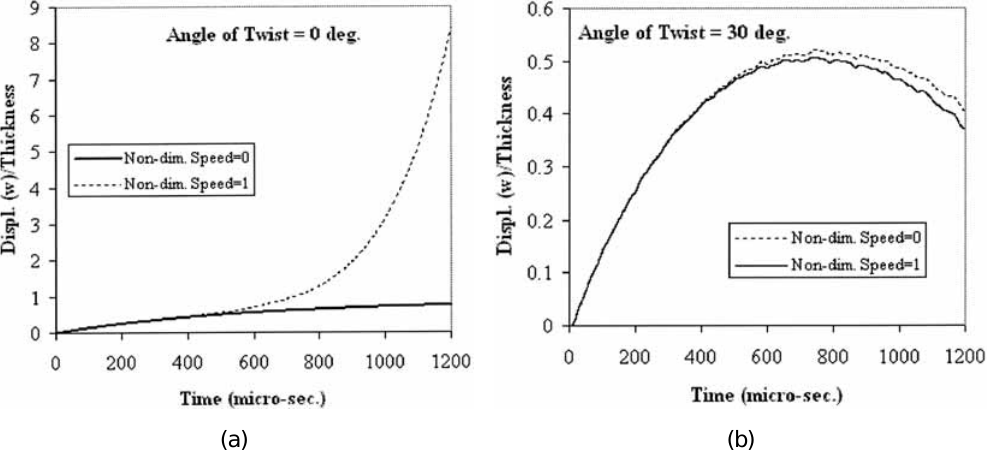
Fig. 5. (a) The effect of rotational speed on central deflection for bending stiff ([0 2 / ± 30] S ) graphite-epoxy composite cantilever cylindrical shell with 25% mid-plane delamination (relative position of centre line at 0.25 from the fixed end). (b) The effect of rotational speed on central deflection for bending stiff ([0 2 / ± 30] S ) graphite-epoxy composite twisted cylindrical shell with 25% mid-plane delamination (relative position of centre line at 0.25 from the fixed